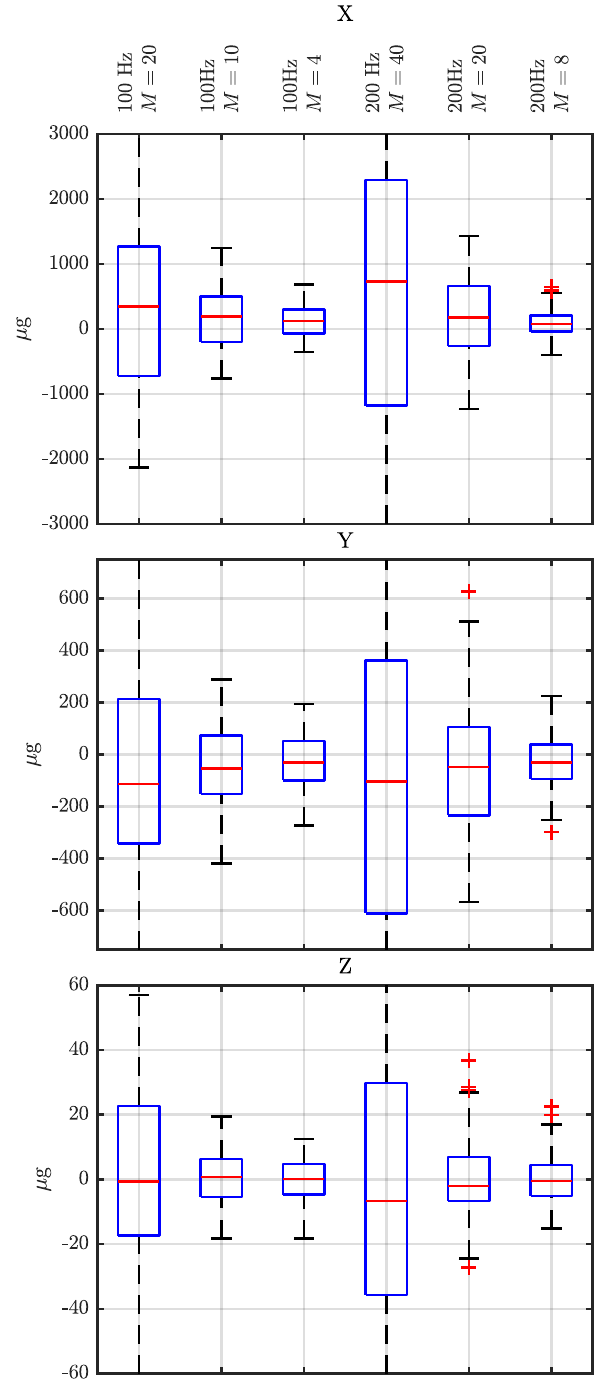
Figure 4. Box plot for the accelerometer bias estimation error in each Monte Carlo run, for each processing